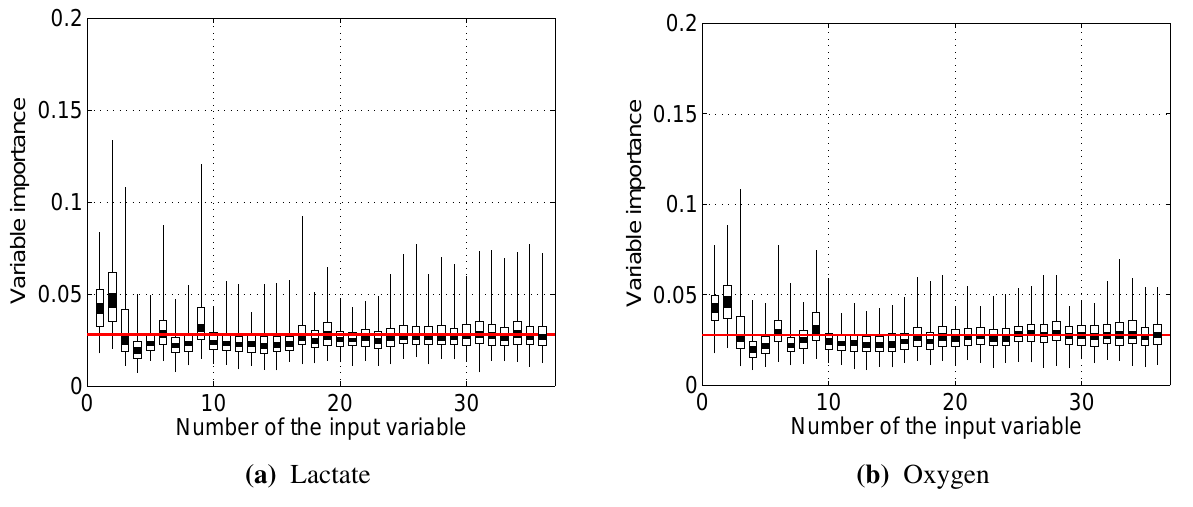
Figure 10. The distribution of the input variable importance for random forest models. Each segment of a bar represents a step of 0.2 quantiles. The red line represents the expectation if all variables were equally important. Variables and their numbers were defined in Section